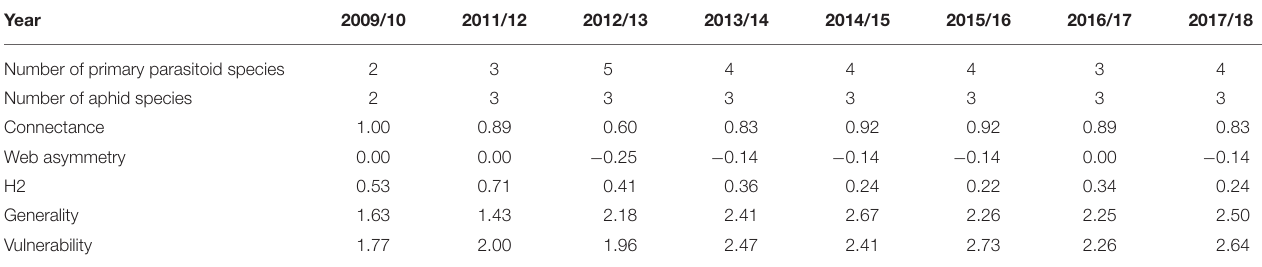
TABLE 1 | Number of species in each trophic level (primary parasitoids and aphids) and food-web metrics for each sampled